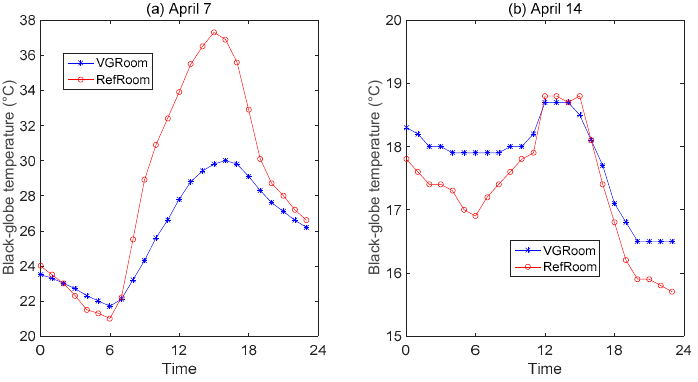
Figure 9. Indoor BGT variations over two typical days.